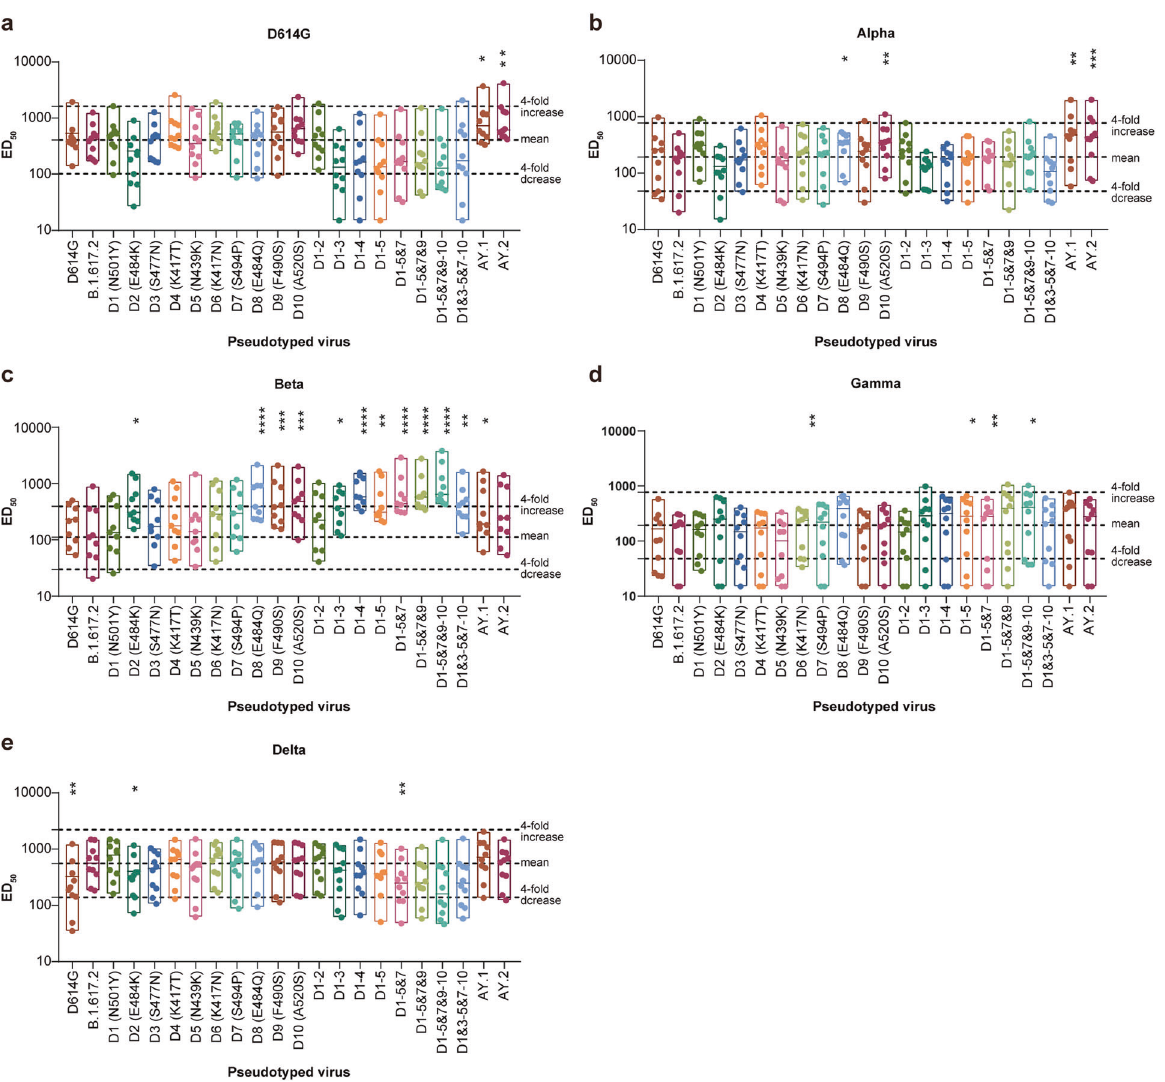
Fig. 3 Neutralization activity of Alpha, Beta, and Gamma S protein- immunized sera against possible Delta variants with multiple amino acid changes in RBD. The S protein trimer from D614G and three VOCs (Alpha, Beta, Gamma) were used individually to immunize mice. Sera were collected and tested for neutralization activity against B.1.617.2 (Delta) variant-based possible variants with multiple amino acid changes in RBD. Mean ED 50 from three repeated experiments are shown as dot plots. The dashed lines represent the geometric mean and fourfold reduction for serum response of the reference Delta variant, respectively. Dashed lines indicate a fourfold difference of ED 50 compared with the Delta reference strain. S spike, RBD receptor binding domain, SARS-CoV-2 severe acute respiratory syndrome coronavirus 2, VOC variant of concern, ED 50 50% effective